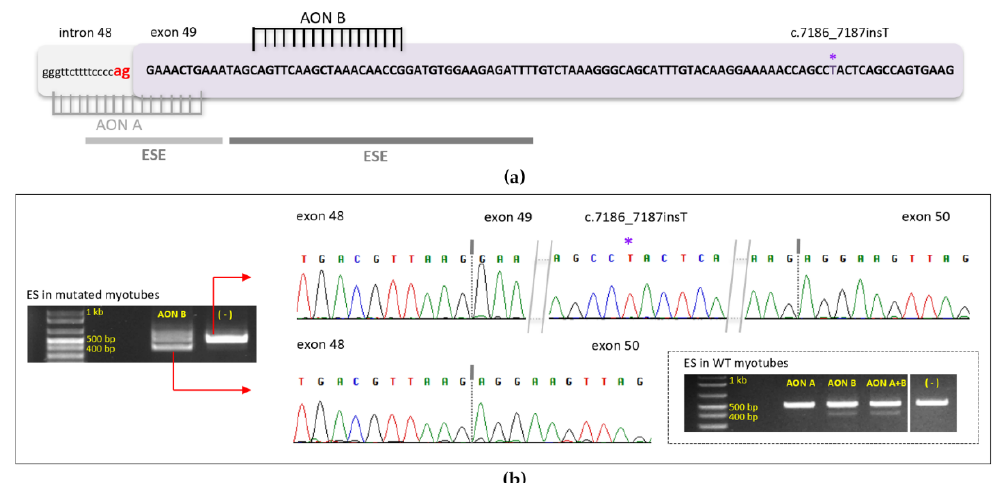
Figure 3. ( a ) Schematic representation of exon 49 DNA sequence in a DMD patient carrying a frameshift variant (asterisk). AON A and B, transfected in WT and mutated myotubes, are represented in grey and black respectively and hybridized to their complementary sequence. AON A masks the canonical (ag) splice site (red), AON B masks a region rich in ESE (exonic splicing enhancer), represented by horizontal lines (color reflects density of ESE presence); ( b ) Results of AON transfection into WT and mutated myotubes are presented. In the dashed rectangle: RT-PCR results after RNA extraction from transfected WT myotubes are shown on electrophoresis migration gel; primers located in exons 47 and 51 were used. In WT, myotubes bands without exon 49 represent 11.68% with AON A alone, 16.87% with AON B alone and 24.42% using AON A plus B. The second migration gel represents the results of transfected myotubes carrying the c.7186_7187insT pathogenic variant (RT-PCR). Exon skipping was done using AON B alone (first lane) and compared to the control (second lane). The band without exon 49 represents 63.28% of all amplified bands. The sequence of represented bands is shown with their respective chromatograms. (ES: Exon skipping, WT: Wild type).